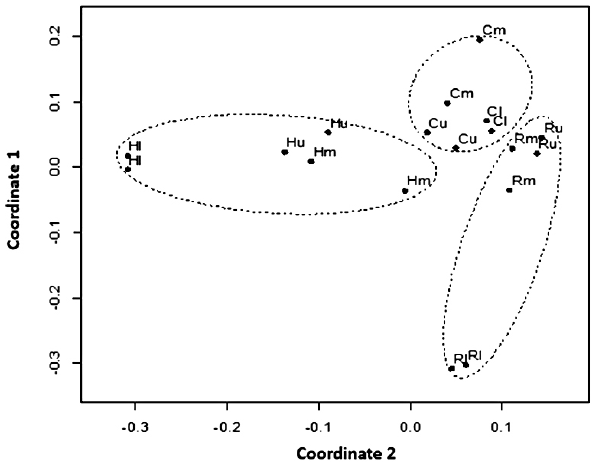
Figure 5. Metric multidimensional scaling analysis based on dis- tance matrix of SSCP profiles of soil sampled from the columns C (uncontaminated soil), H (contaminated by the raw waste contain- ing oily compounds and radionuclides), and R (contaminated by treated waste containing mainly radionuclides) on different layers [upper (0–20cm; u ), middle (20–40cm; m ), and lower (40–60cm; l